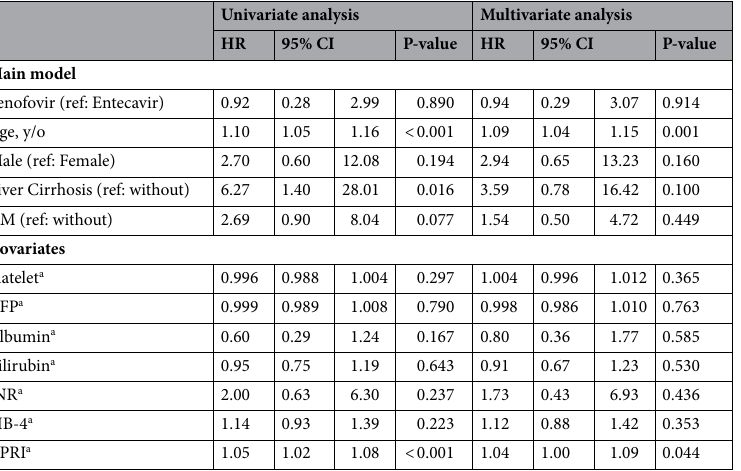
Table 5. Risk factors for ICC in PS matched cohort. PS propensity score, HR hazard ratio, CT confidence interval, DM diabetes mellitus, AFP alpha-fetoprotein, INR international normalized ratio, FIB-4 fibrosis index based on 4 factors, APRI AST to platelet ratio index. a Adjusted for tenofovir, sex, age, liver cirrhosis,